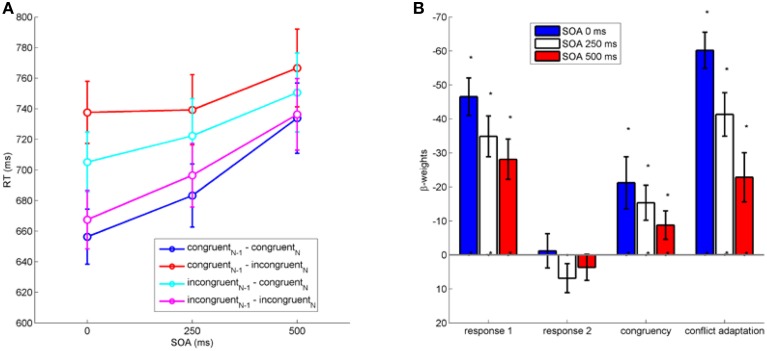
(A): RT1 as a function of stimulus onset asynchrony (SOA in ms) between the stimulus of Task 1 and Task 2. (B): Results of multiple regression analysis on RT1 (in ms) with all hypothesized factors. Negative weights indicate a decrease in RT. Error bars represent standard errors of the mean. Asterisks indicate significant differences from zero at the 0.05 level (see main text).